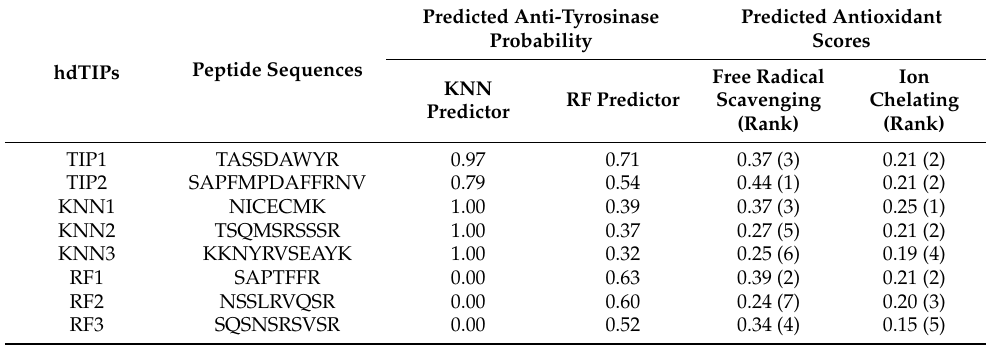
Table 1. Abalone predicted TIPs by KNN and RF-based predictors and the predicted antioxidant scores by AnOxPePred 1.0